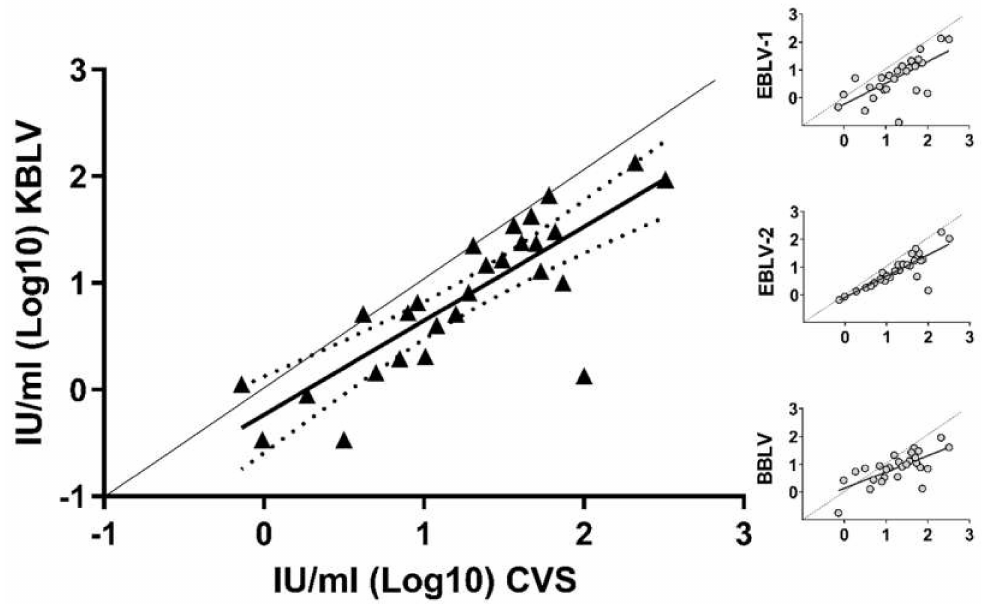
Figure 3. Graph showing individual concentrations of virus neutralizing antibodies as measured using CVS ( x -axis) and RABV pseudotyped with KBLV-G as test virus ( y -axis), plotted in double-logarithmic graphs. The 95% confidence intervals (CI; Bonferroni corrected) of the best-fit regression line are indicated (dashed lines). Insets: Comparative analyses using the same sera and EBLV-1, EBLV-2 and BBLV as test viruses ([47], Table